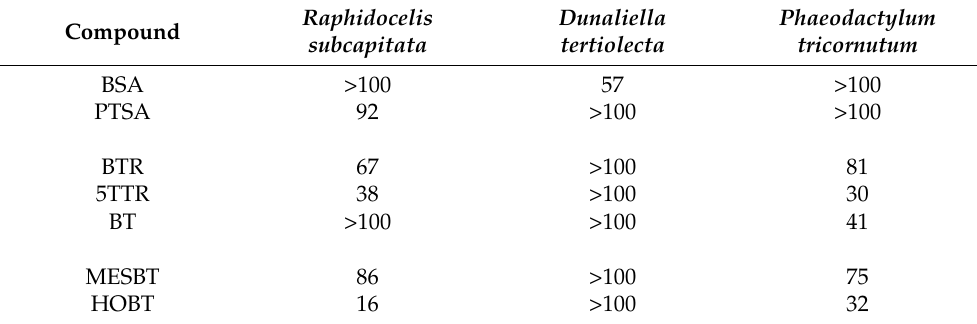
Table 1. EC 50 values of the various compounds calculated for the three algae, in mg L − 1 . The value “> 100” means that the maximum concentration tested (100 mg L − 1 ) produced an inhibition lower than 50%.